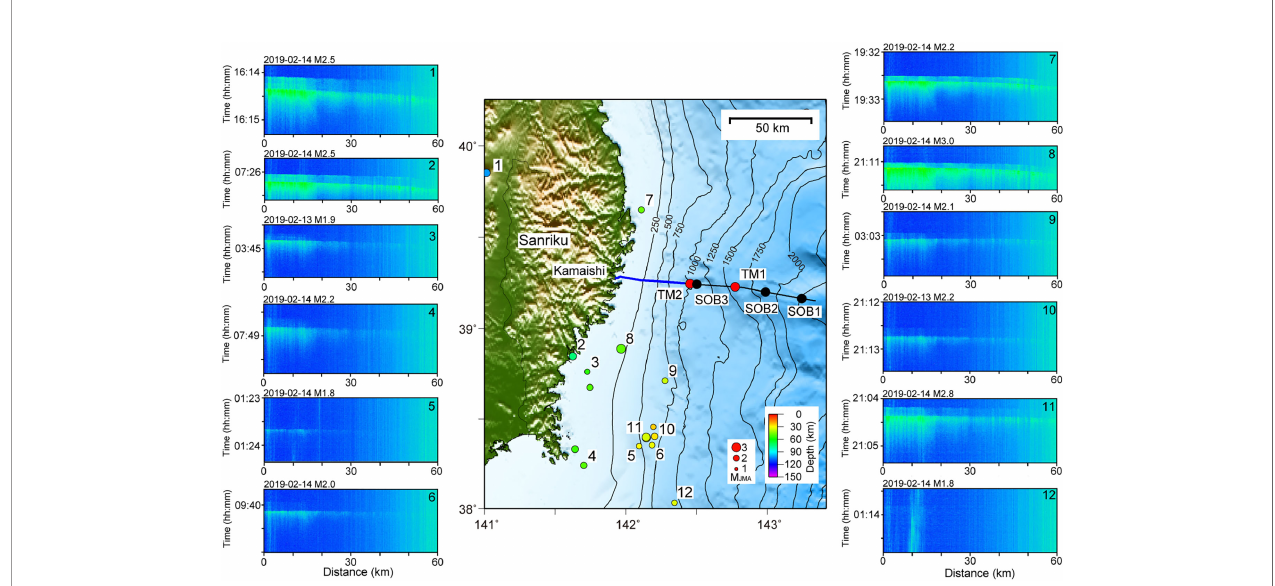
FIGURE 2 | FBE data of local earthquakes recorded by the DAS measurement using the Sanriku cable system. FBE data show the energy of strain rate in a frequency band from 10 to 20 Hz. Position of the sea fl oor cable for the DAS measurement is indicated by blue and black lines. Event numbers are shown in the FBE data, and epicenters are indicated by numbers on the map.